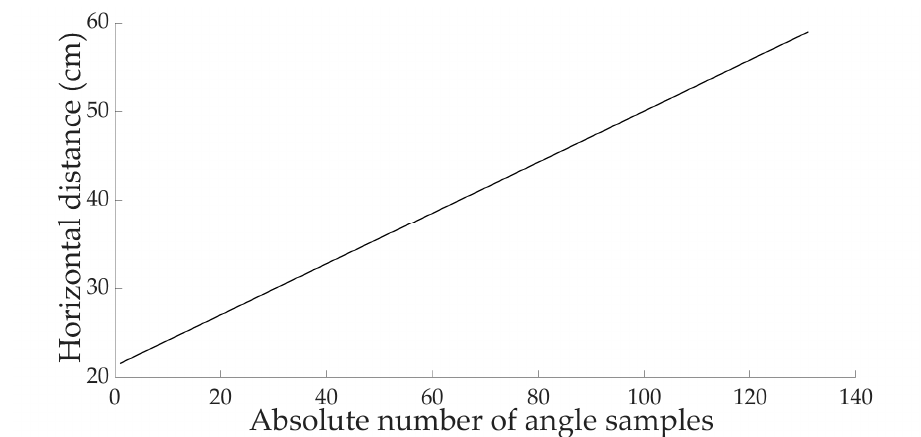
Figure 1. Linear interpolation of horizontal distance (group mean) between origin and